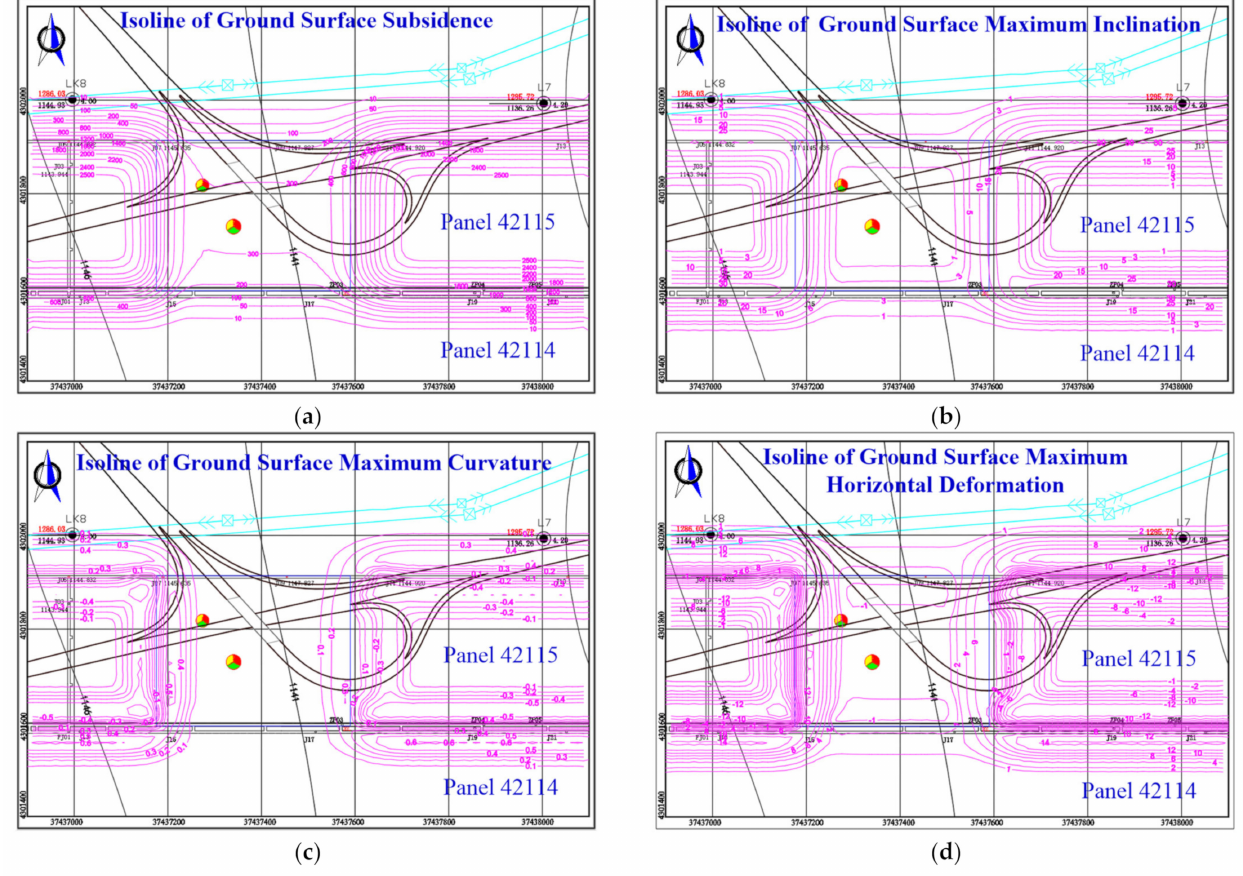
Figure 14. Prediction results of surface deformation after 42,115 working face backfill mining. ( a ) Ground surface subsidence; ( b ) Ground surface inclination; ( c ) Ground surface curvature; ( d ) Ground surface horizontal